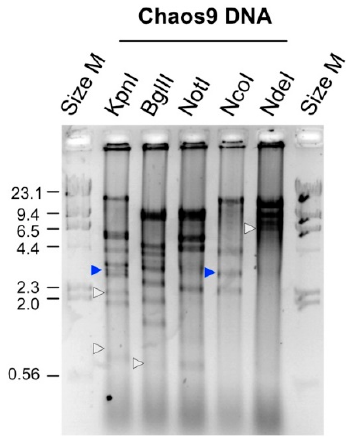
Figure 3. Restriction digests of ChaoS9 DNA. Enzymes used are indicated above each well. The outside wells (Size M) were loaded with DNA size markers (Lambda-HindIII), and the fragment sizes (in kbp) are shown at the left edge. White triangles; terminal fragments predicted from the DNA sequence that were either underrepresented or not visible on gels. Blue triangles; bands predicted from the DNA sequence to occur only in longer than unit length genomes. See also Supplementary Figure S1.